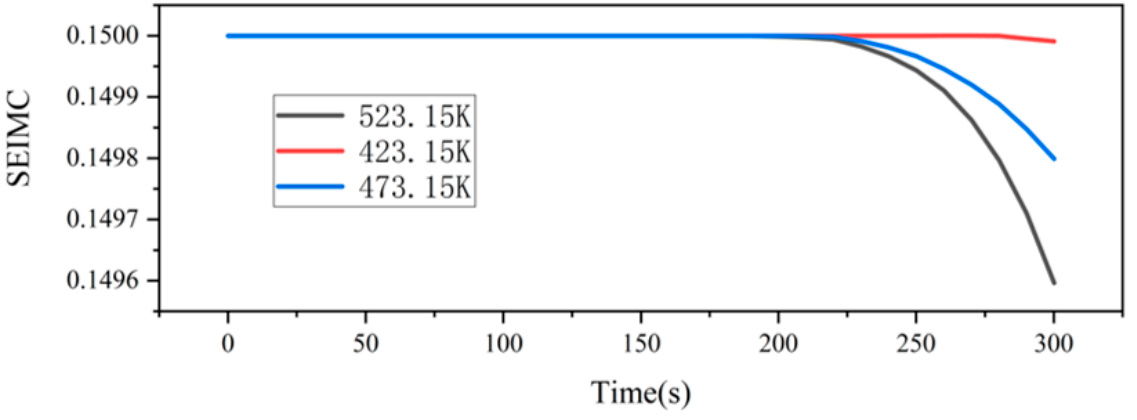
Figure 2. Variation of each component of the different side reactions: ( a ) 423.15 K; ( b ) 473.15 K; and ( c ) 523.15 K.